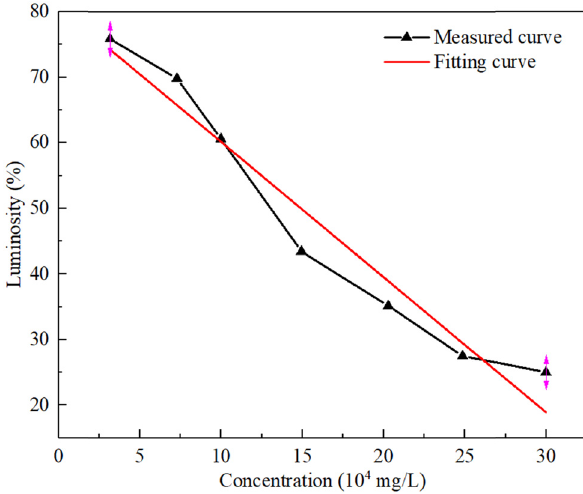
Figure 7: The biological toxicity EC 50 test linear regression curve of RH - β - CD.